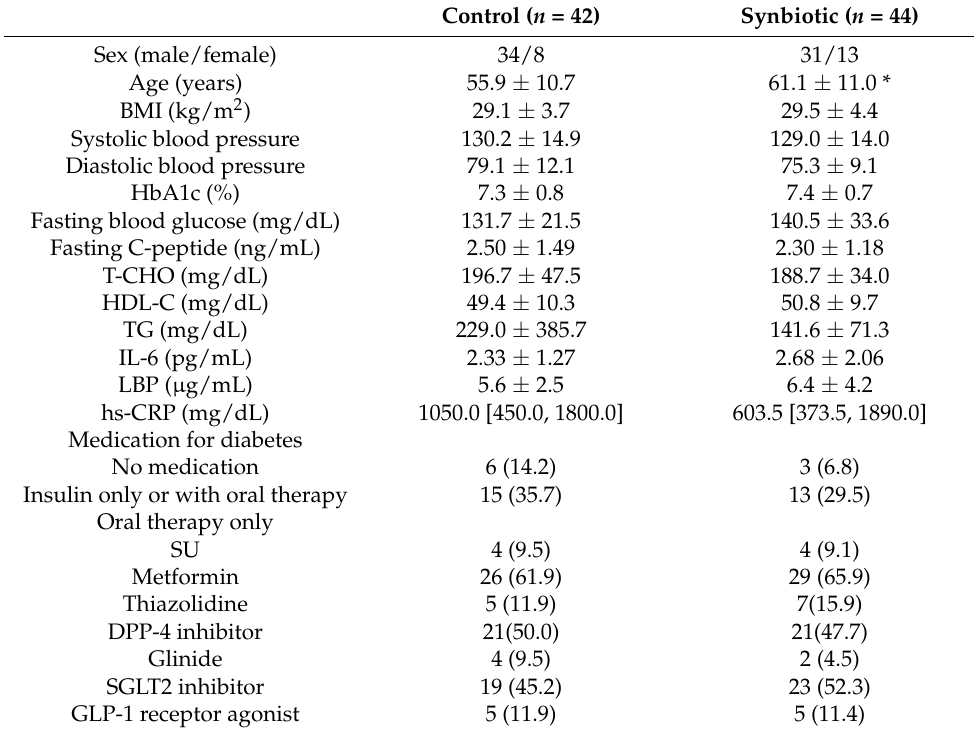
Table 1. Subject characteristics at baseline.